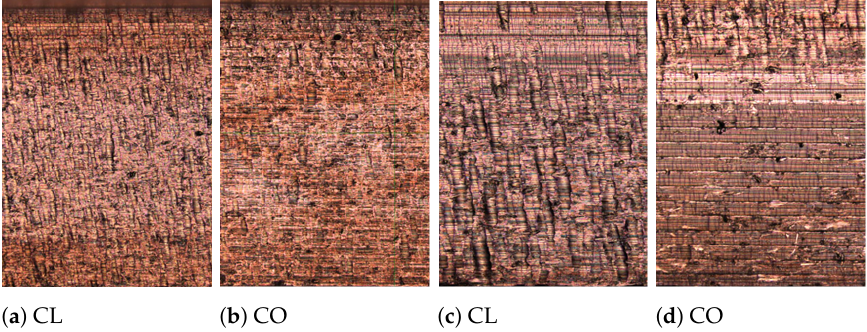
Figure 3. Microscope images of the channel sides roughness: CL = Climb-milled side, CO = Conventionally-milled side; ( a , b ) W = 200 µm, ( c , d ) W = 300